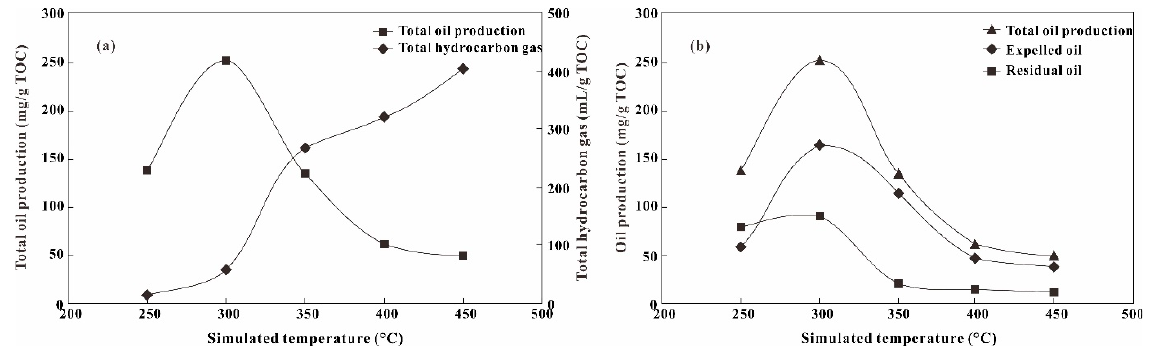
Figure 2. The diagram of simulated products: ( a ) changes in total oil production and total hydrocarbon-gas production during the simulation experiment and ( b ) comparison of total hydrocarbon, expelled oil and remaining oil.